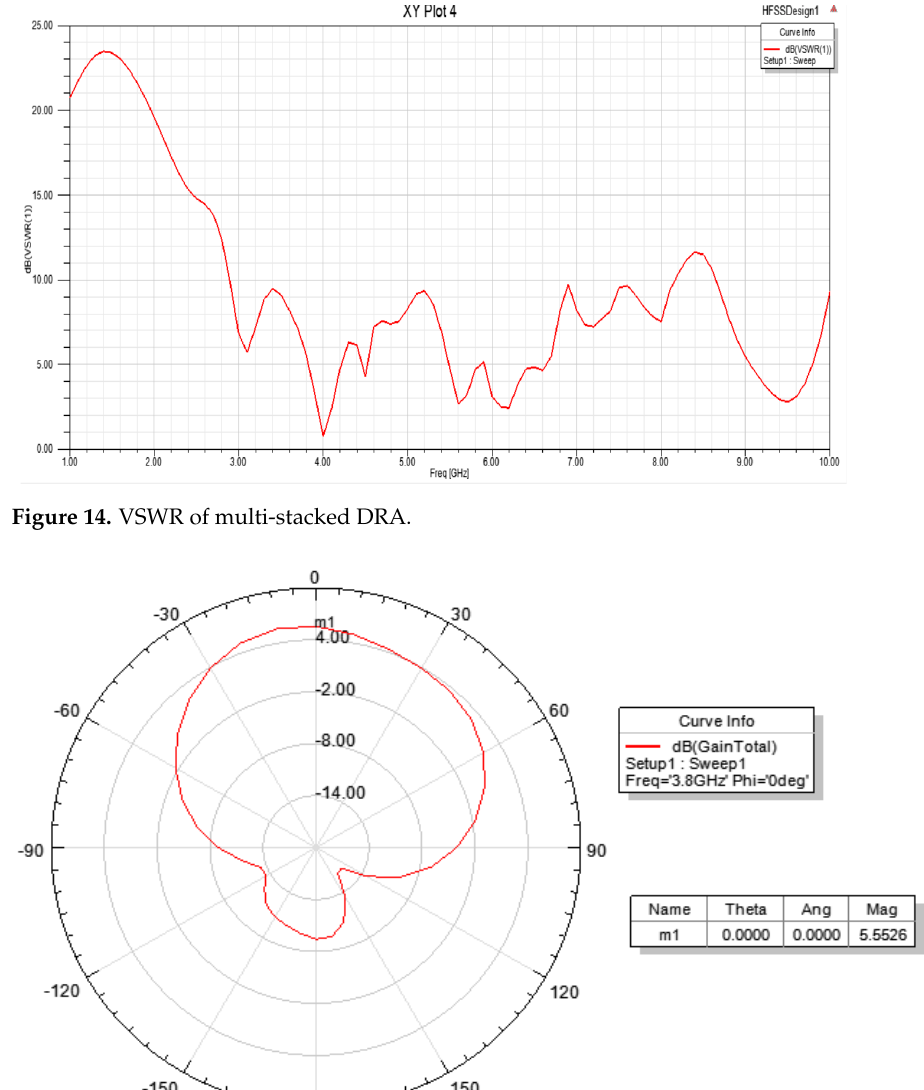
Figure 13. S11 plot of multi-stacked DRA.